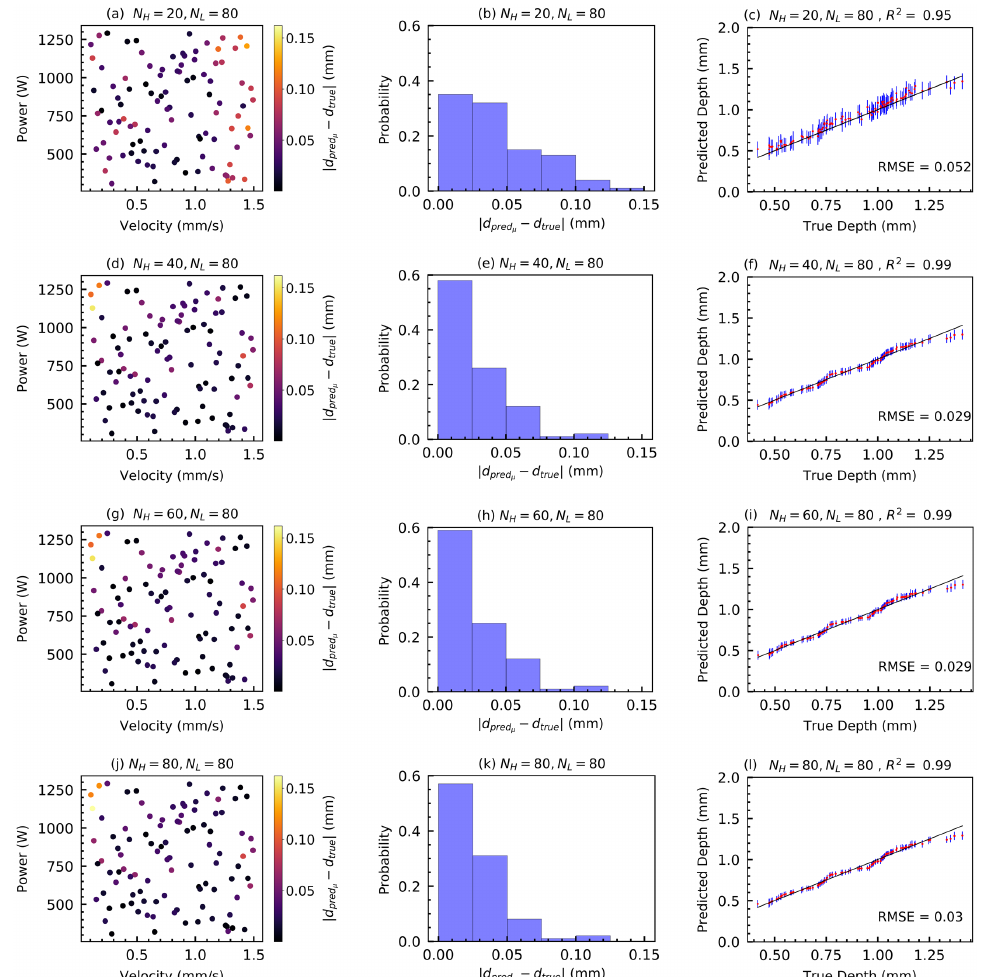
Figure 11. Effects of adding HF data to MFGP surrogates. ( a , d , g , j ) Variation of the absolute error | d − d true | over X test as a function of N H . N H is varied from 20 to 80, in steps of 20, while pred µ keeping N L constant at 80. Each circle on the figure indicates the error at a test input data point in X test . ( b , e , h , k ) Histograms approximating the probability distribution of the absolute errors in the prediction over X test . The bin probabilities indicate the fraction of points in the test set for which the absolute values of the prediction error lie within the respective bin limits. ( c , f , i , l ) Parity plots comparing the true depths at X test (sorted in an increasing order of magnitude) with the corresponding depths predicted by the respective MFGPs, along with the RMSEs of prediction. The predicted depth, being probabilistic, is represented by a filled circle indicating the mean ( µ ), and vertical bars indicating the associated uncertainty in prediction ( µ ± 1.0 σ pred ). The individual figure captions also include the coefficient of determination, R 2 in the predicted mean melt pool depths for the respective MFGP